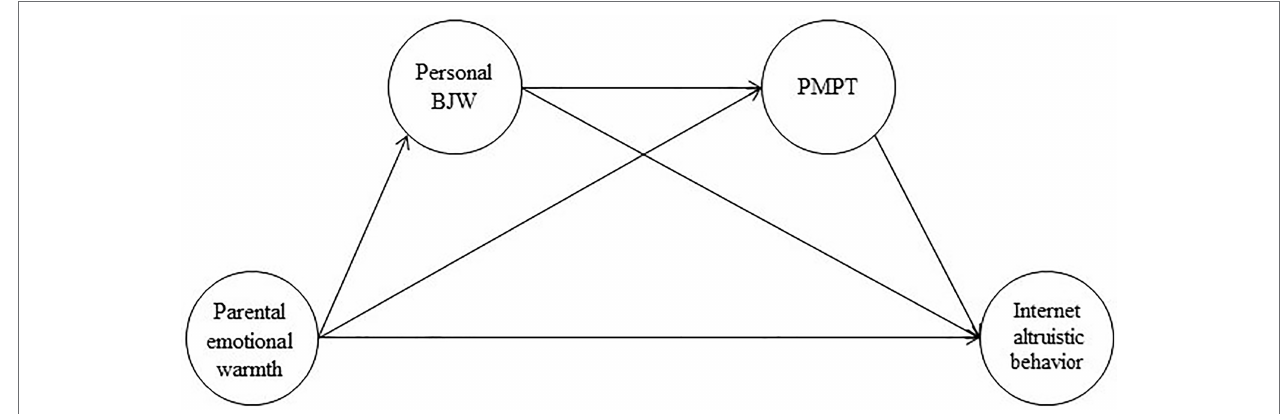
FIGURE 1 | The proposed mediation